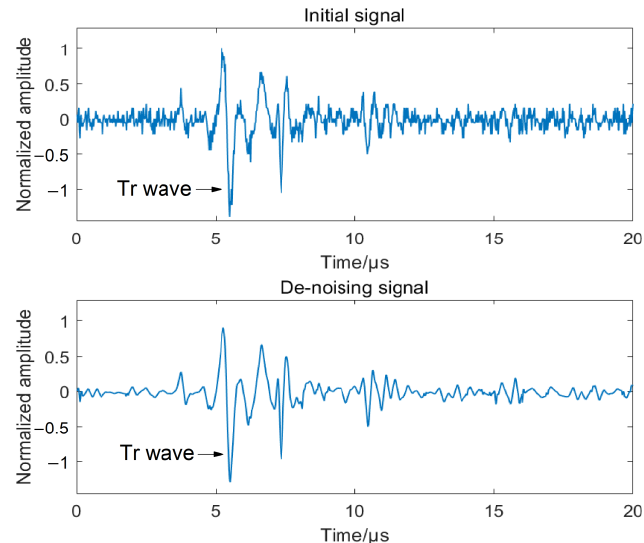
Figure 23. Initial signal and denoising signal of the Tr wave. Figures 22 and 23 clearly show the positions of the transmitted wave, direct wave and reflected wave. The seven feature parameters based on experimental signals are included in the SVM model. Then, to show the linear relationship between the crack angle, depth, and experimental data, the data of seven feature parameters are transferred to one dimension using the KPCA method. The results are shown in Figures 24 and